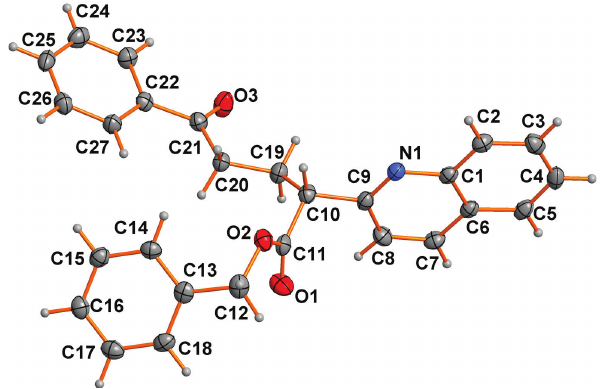
Table 2: Fractional atomic coordinates and isotropic or equivalent isotropic displacement parameters (Å 2